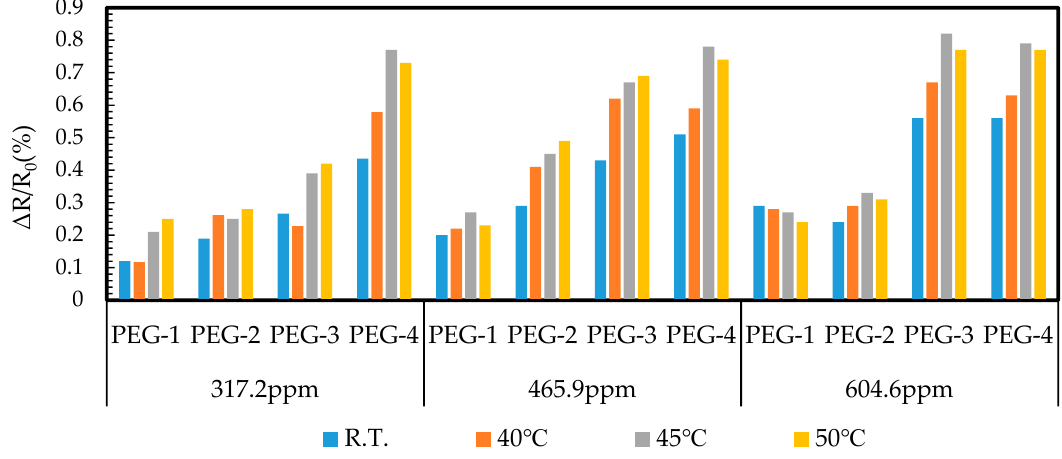
Figure 13. Response of sensor expsoure to different concentrations of acetone at different operating temperatures.